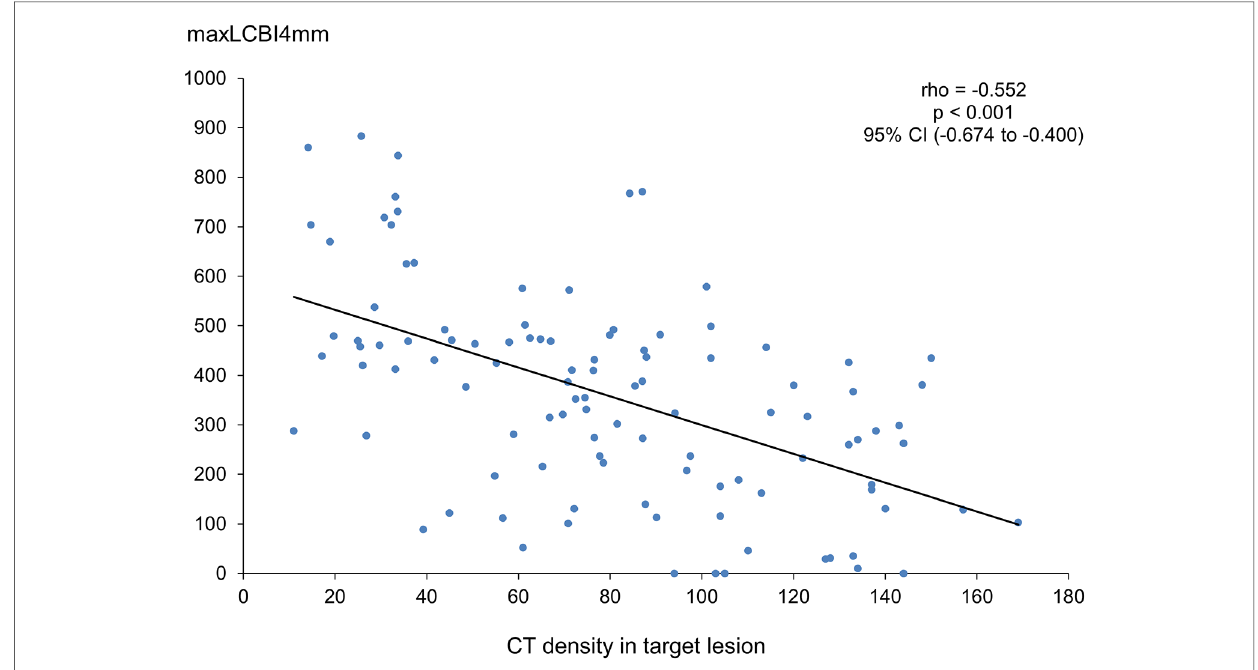
FIGURE 4 Correlation between CT density and maxLCBI4mm. CT, computed tomography; maxLCBI4mm, maximum value of the lipid-core burden index for any 4-mm segment; CI, con fi dence interval.